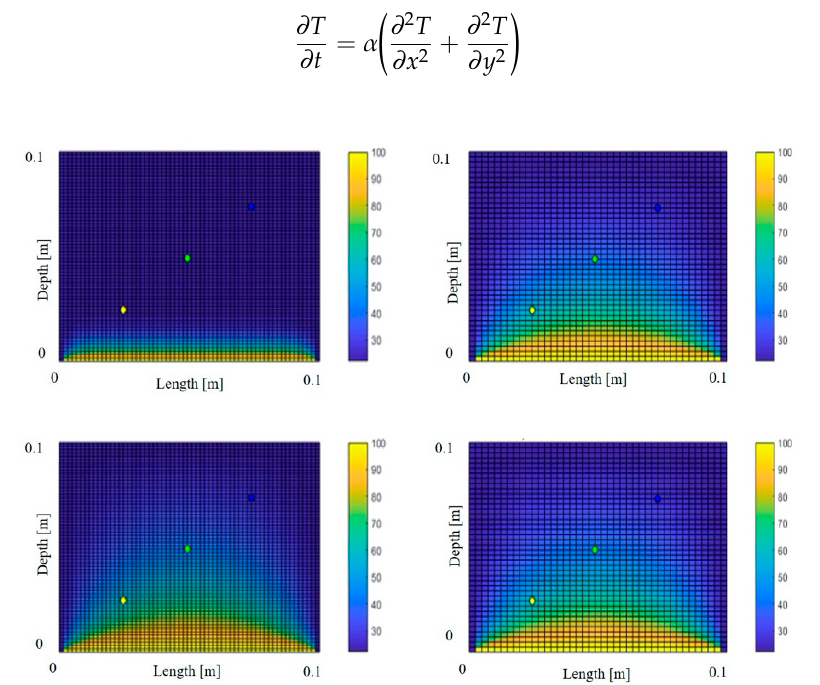
Figure 4. Temperature fields for Kapton ® ( left ) and Al ( right ): in the bottom part, steady state graphs; on the top, transient state analysis.